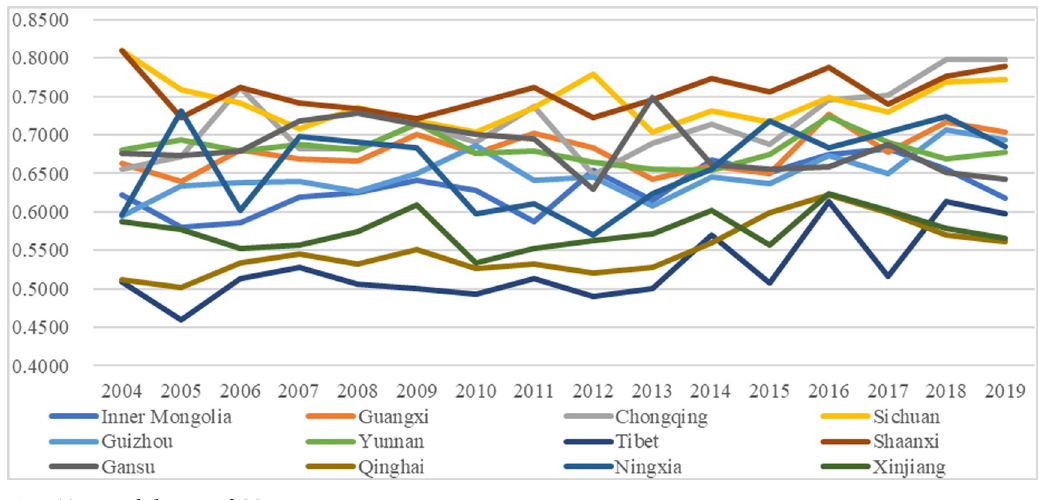
Fig 6. Temporal changes of